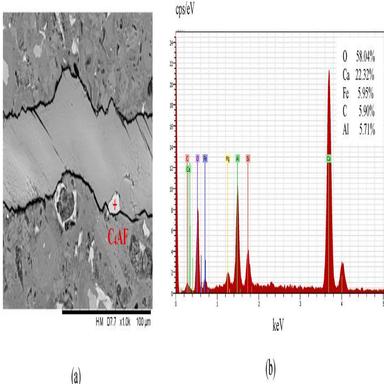
Sample with 2% CA: (a) SEM micrograph (BSE image) of a typical polished section, showing a crack with healing products, particularly C4AF; (b) EDS microanalysis (spectrum and quantification of elements above 1%) of the C4AF grain pointed out by the red cross. (For interpretation of the references to colour in this figure legend, the reader is referred to the Web version of this article.)